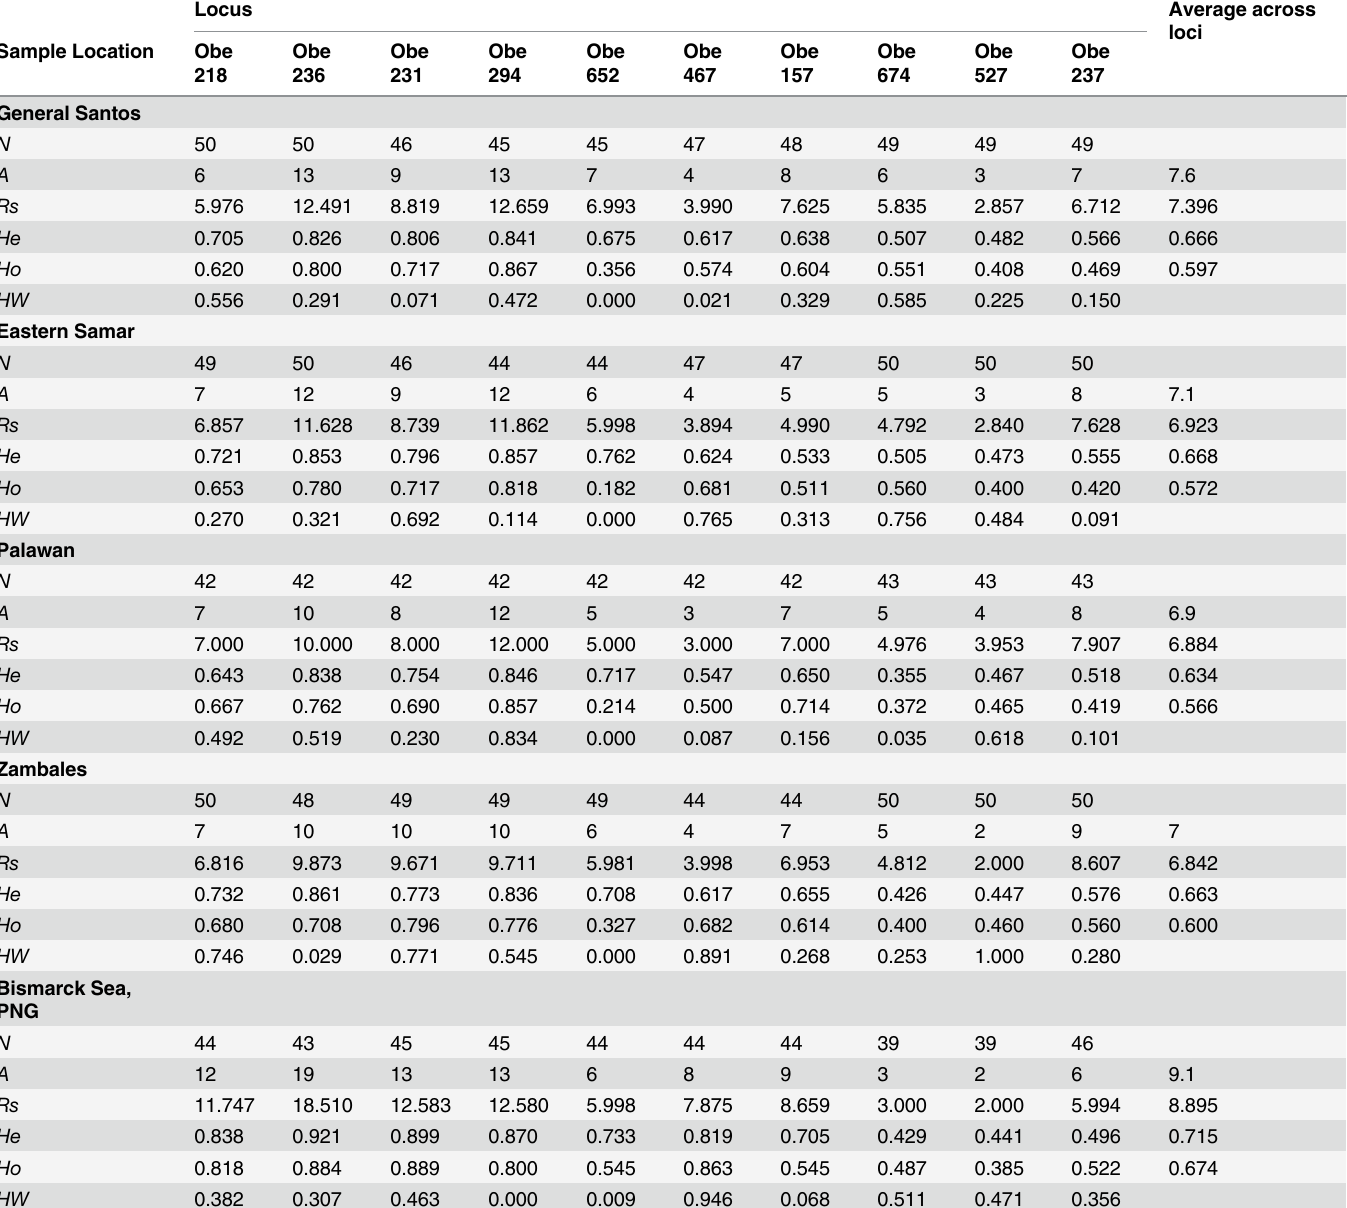
Table 2. Descriptive statistics of nine microsatellites in Thunnus albacares